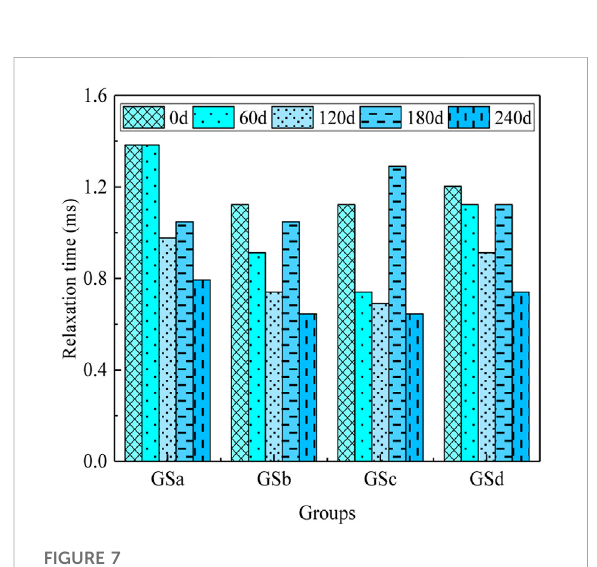
FIGURE 7 Relaxation time of the fi rst